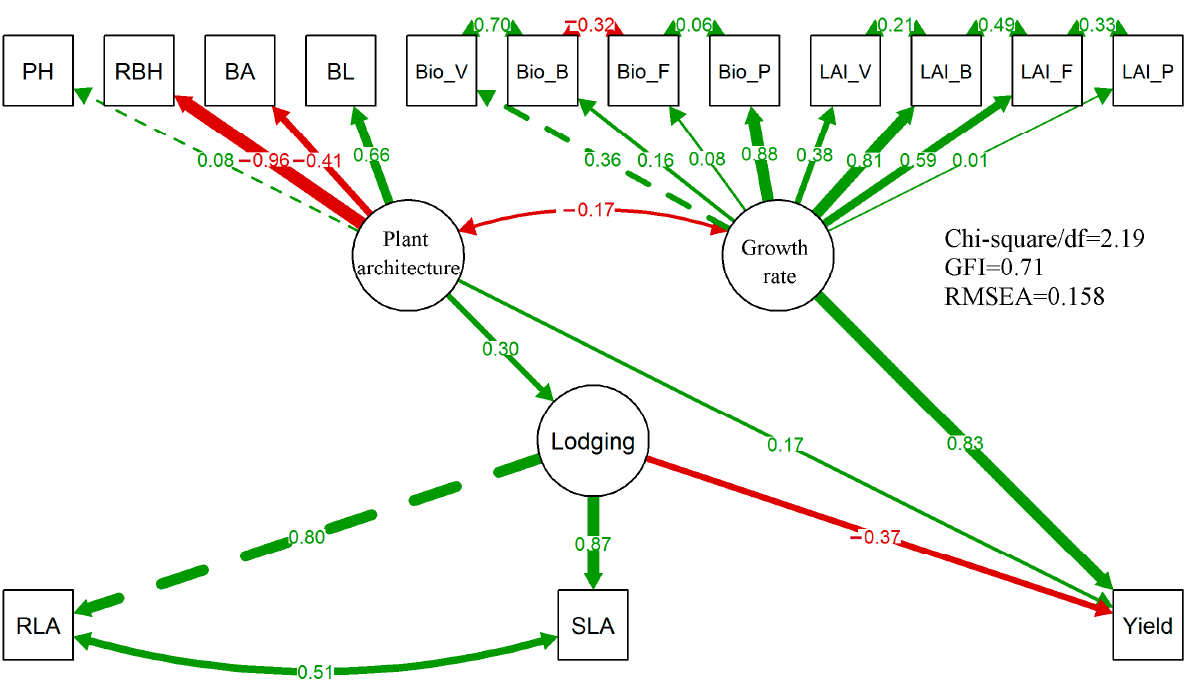
Figure 7. Path analysis to show the contribution of plant architecture, lodging, and growth rate to seed yield. Green arrows revealed positive relationships, while red arrows revealed negative relationships. Values at arrows were standardized path coefficients. PH, plant height; RBH, relative branch height; BA, branch angle; BL, branch length; Bio_V, Bio_B, Bio_F, and Bio_P represent the dry plant biomass at vegetative, bolting, flowering, and podding stages; LAI_V, LAI_B, LAI_F, and LAI_P represent the leaf area index at vegetative, bolting, flowering, and podding stages; RLA and SLA represent the root lodging angle and shoot lodging angle, respectively. The circle and rectangle indicate the measurable and latent variables, respectively. Table 3. Weight of each indicator based on the D-CRITIC method for the growing seasons of 2020–2021 and